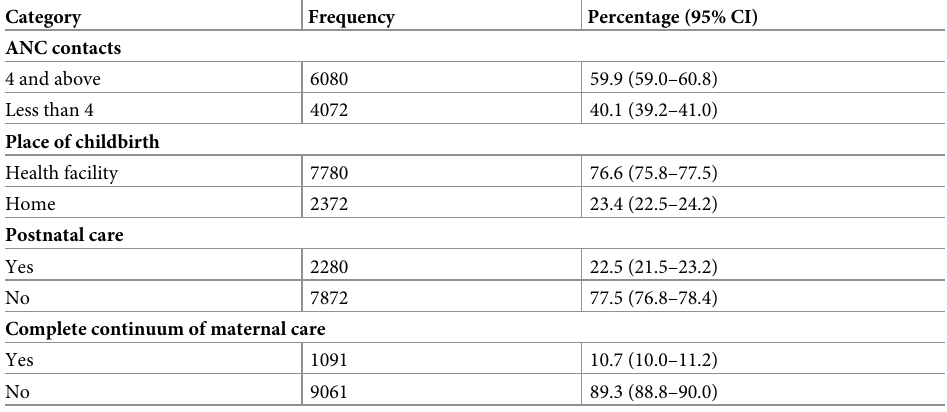
Table 2. Level of utilization of the various maternal and child health